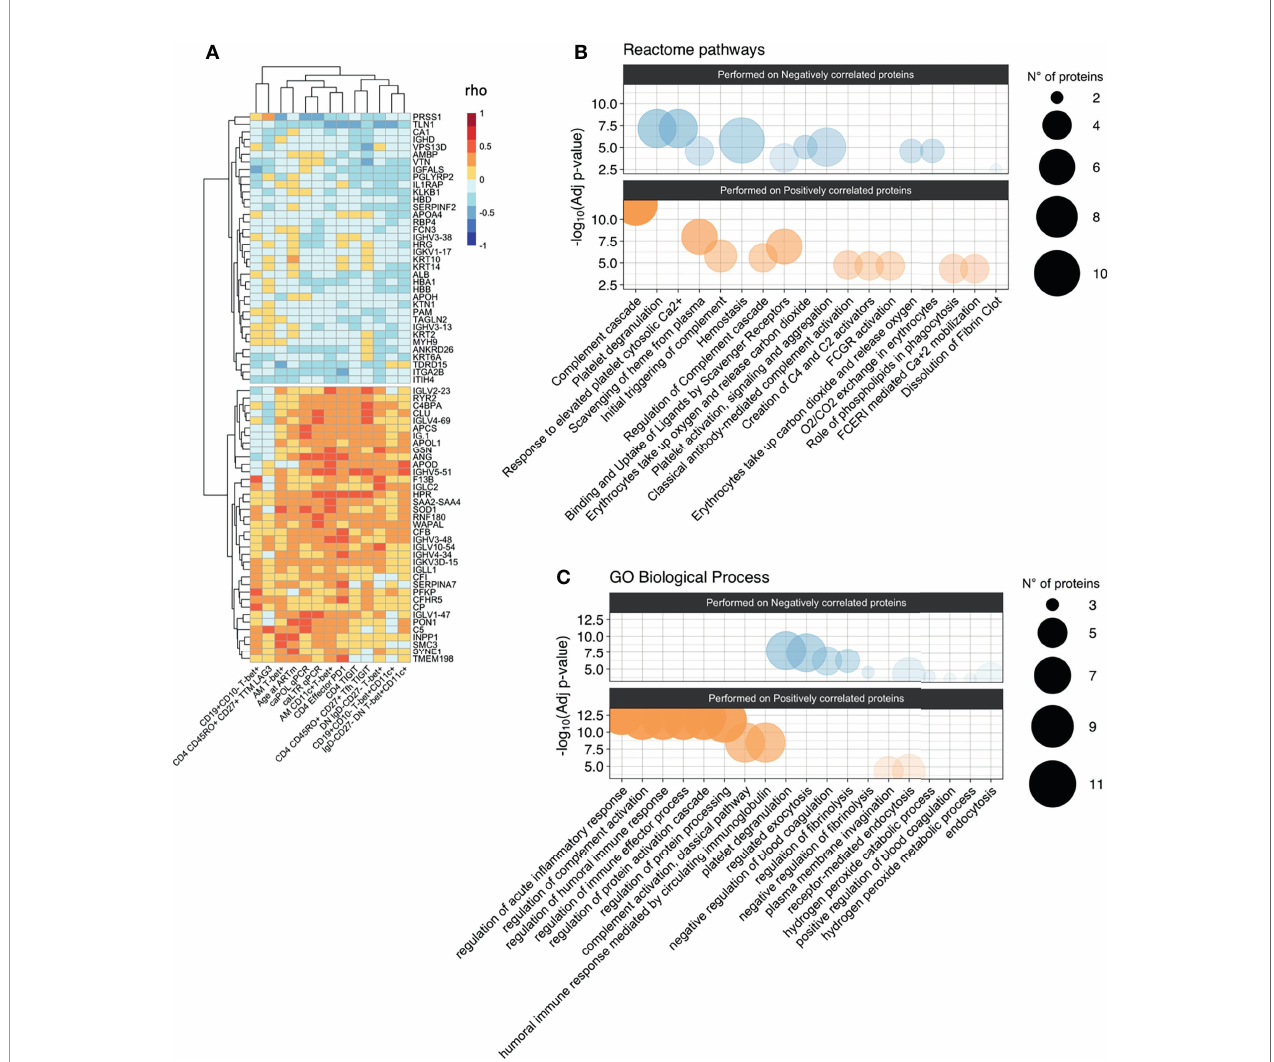
FIGURE 3 | Association between proteomic pro fi ling and levels of hyperactivated B-cells and exhausted T-cells. (A) Heatmap plot showing Spearman correlations between the 13 unfunctional features values and the abondance of the 73 plasma proteins belong to the two clusters identi fi ed in correlation matrix with all 338 proteins. Red indicates positive correlations and Blue negative ones. Bubble plots showing the top 10 Reactome pathways (B) and GO Biological Process (C) signi fi cantly enriched (Adjusted p-value < 0.05) in proteins positively (Pos) and negatively (Neg) correlated with the 13 unfunctional features. The proteins were separated into positively and negatively correlated based on the two clusters showed in the correlation heatmap in panel (A) Colors are related at the log 10 adjusted p-value values and the circle diameter are related at the number of proteins for each term. Signi fi cance was set at